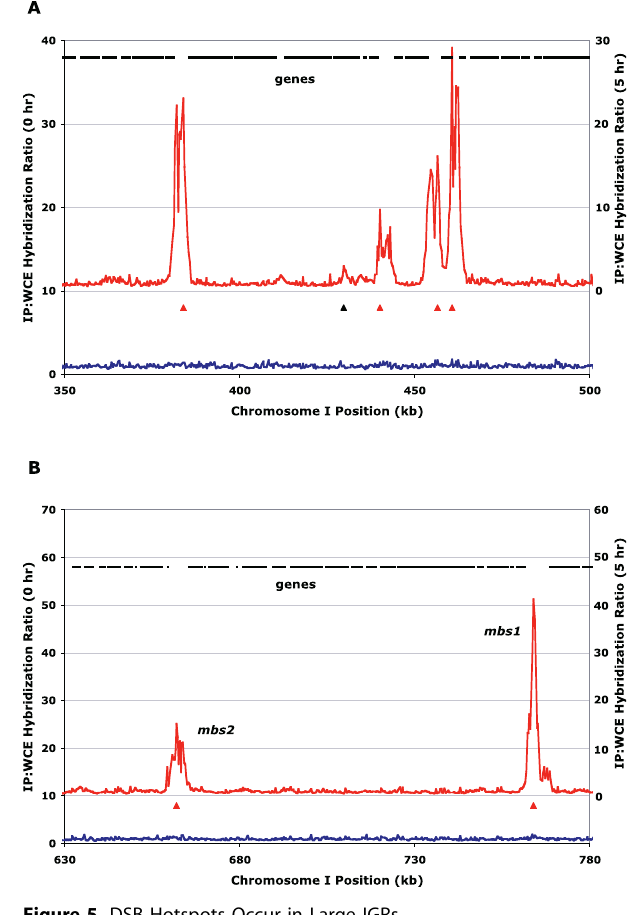
Figure 5. DSB Hotspots Occur in Large IGRs Microarray data for haploid 0-h DNA (blue line), the mean of two 5-h DNA analyses (red line) processed as in Figure 1, and coding sequences (genes, black lines at top) from the annotated S. pombe genome (Build 1.1; http://www.ncbi.nlm.nih.gov/entrez/query.fcgi?db ¼ genomeprj& cmd ¼ Retrieve&dopt ¼ Overview&list_uids ¼ 9517) are shown for two 150- kb intervals of Chromosome I. (A) An interval to the left of that containing mbs2–mbs1 (see Figure 1) . (B) The mbs2–mbs1 region. Carets indicate weak (black) and prominent (red) Rec12 peaks identified by